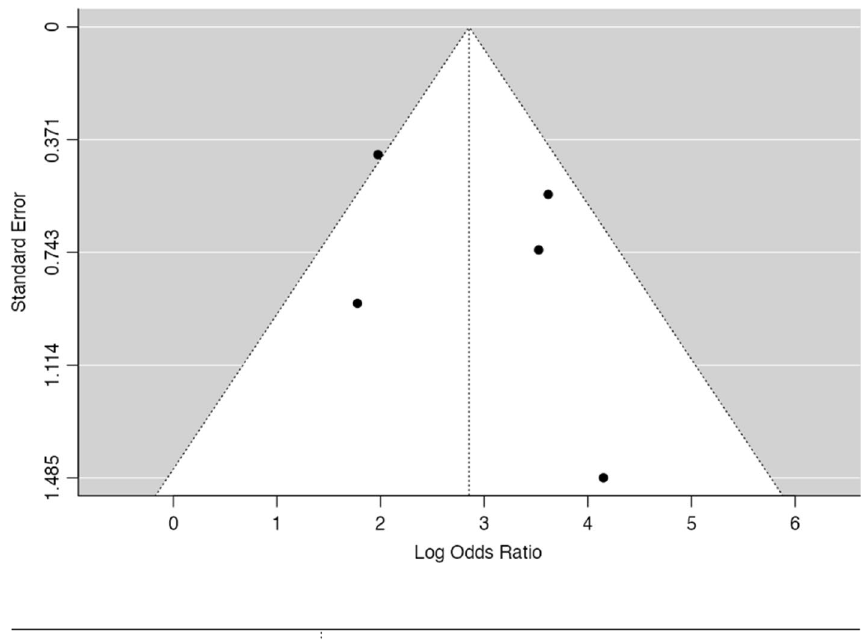
Fig. 10 Forest-plot describ- ing the proportion of PD-L1 positivity in GCLS